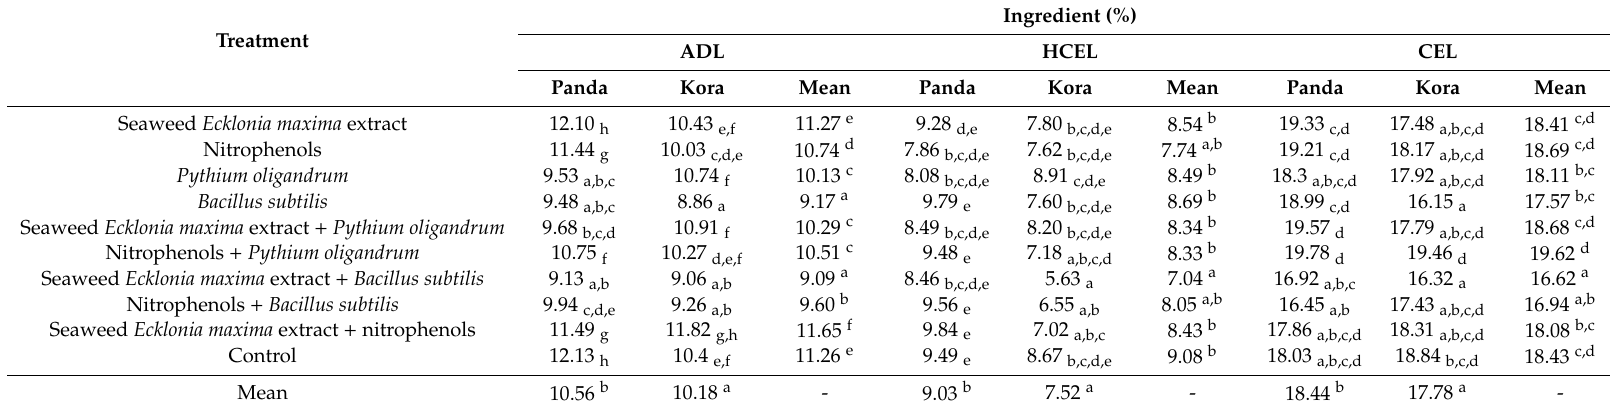
Table 3. E ff ect of cultivar and treatment on the acid detergent lignin (ADL), hemicellulose (HCEL), and cellulose (CEL) of buckwheat sprouts.